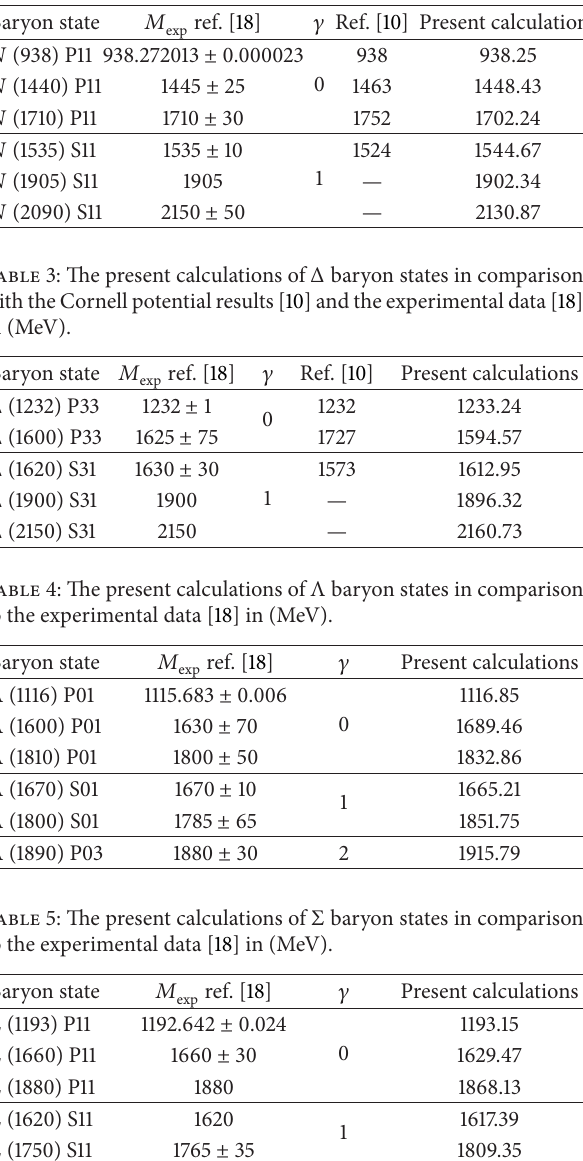
Table 2: The present calculations of 𝑁 baryon states in comparison to the Cornell potential results [10] and the experimental data [18] in (MeV).